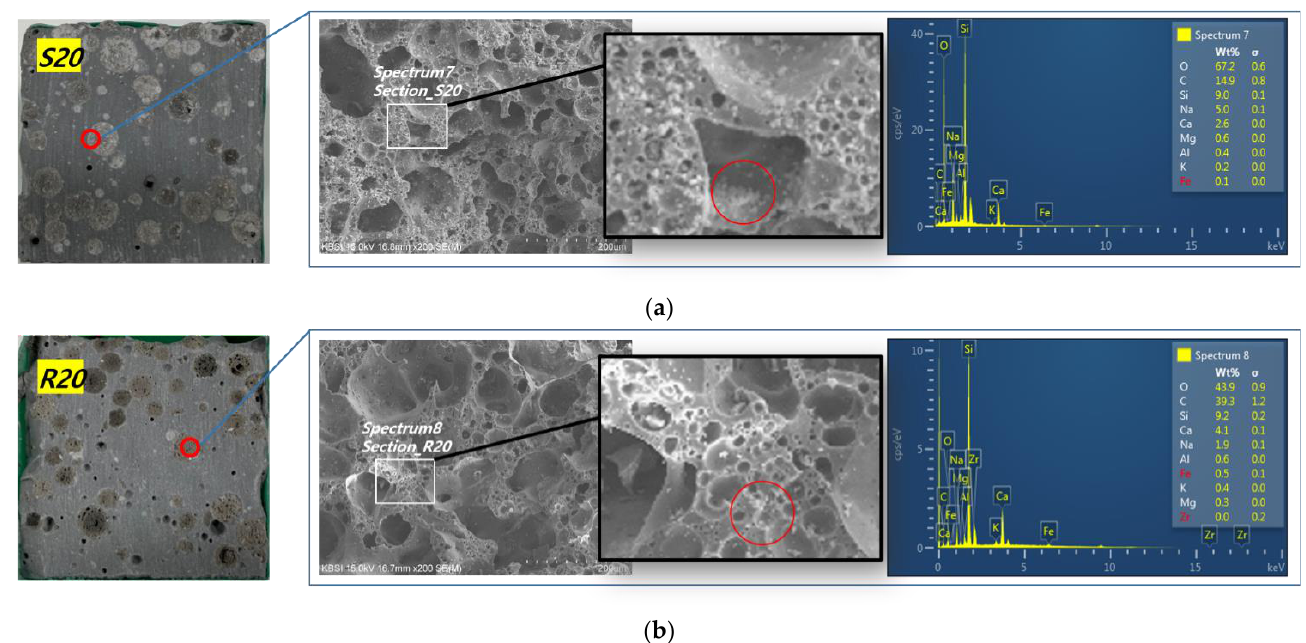
Figure 10. Cross sections of test specimens mixed with WGBs that confirm the state of the moisture trapped inside WGBs: ( a ) S20; and ( b ) R20 specimens.